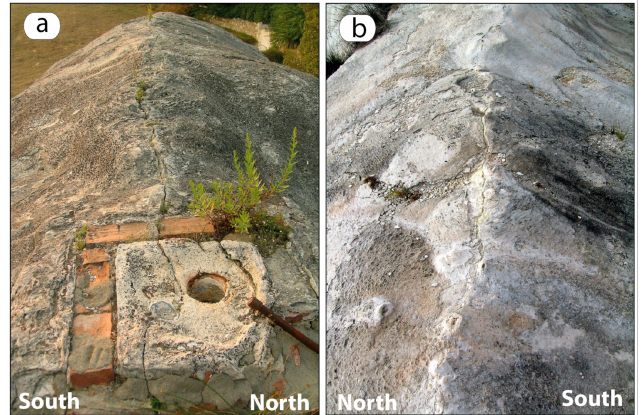
Figure 5. Incipient fissure affecting the apical part of the neoformed travertine deposit (Terme San Giovanni fissure ridge, Rapolano Terme, Italy). ( a ) the fissure is affecting artefact installed on the top in the 1950s. ( b ) the fissure is dissecting travertine deposited in recent